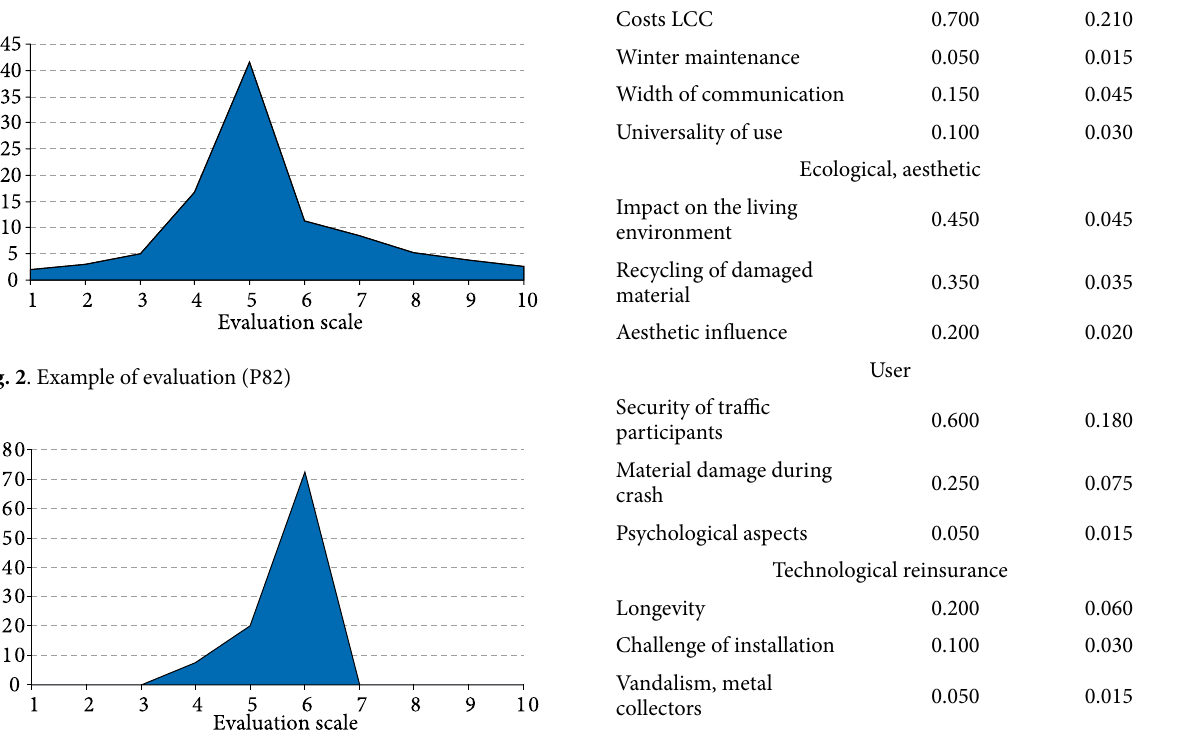
Fig. 1 . Example of evaluation